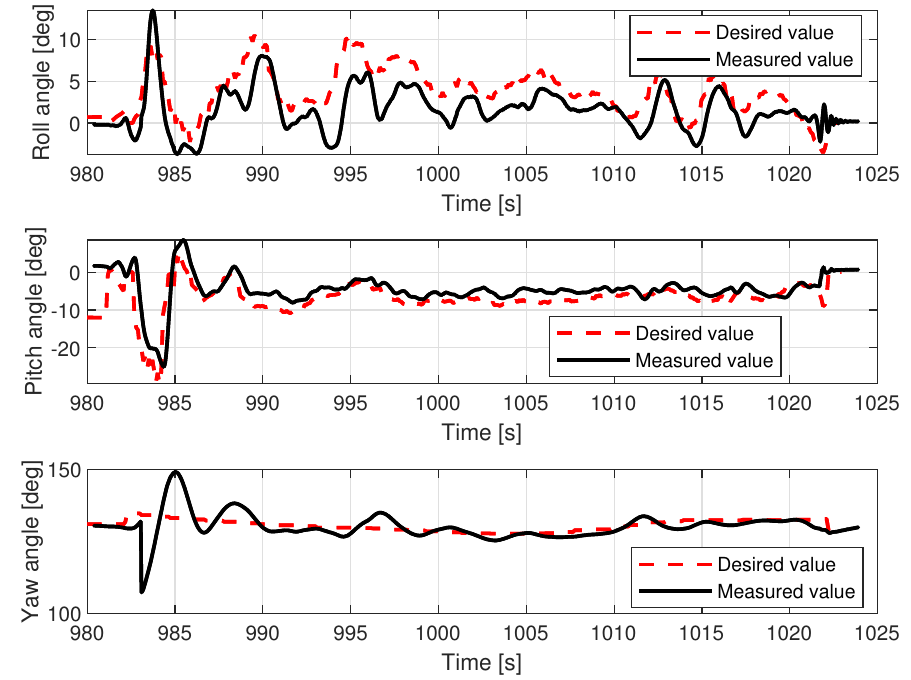
Figure 13. VTOL roll, pitch, and yaw angles during the in-flight test. The lower control quality with regard to roll angle affected the lateral movement velocity